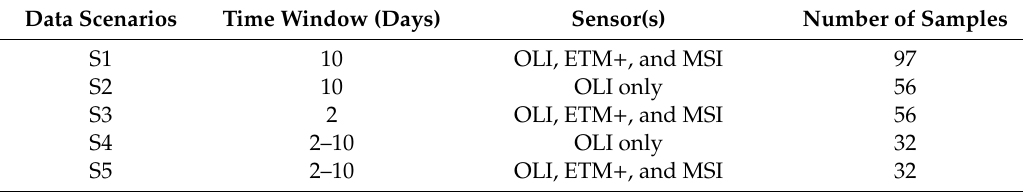
Table 2. Testing scenarios with di ff erent search time windows and multi-sensor